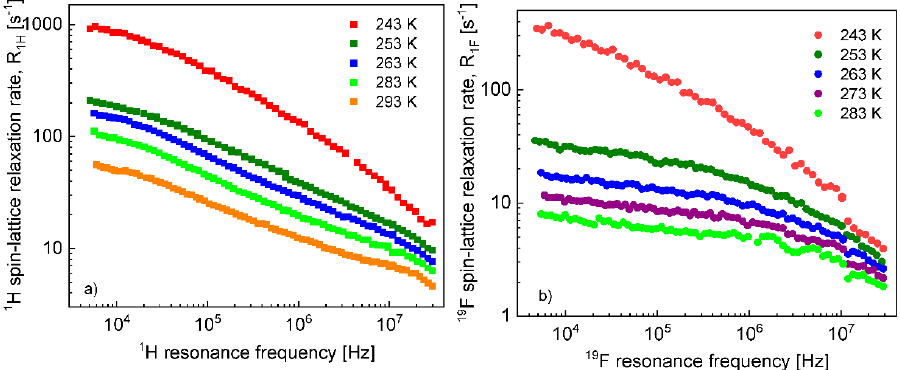
Figure 4. 1 H ( a ) and 19 F ( b ) spin–lattice relaxation ratesfor EMIM-FSI in the silica matrix.